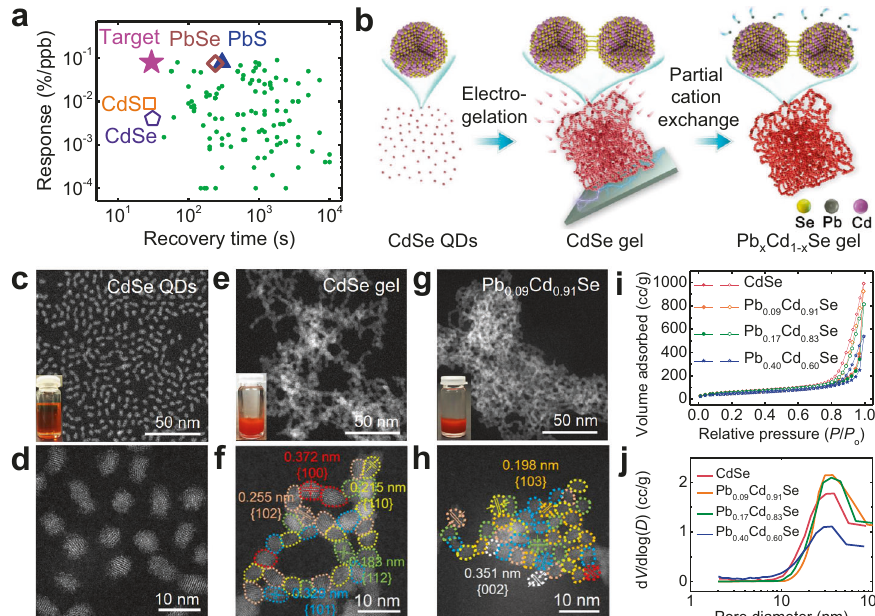
Fig. 1 Synthesis of Pb x Cd 1 − x Se QD gels. a Comparison of CdS, CdSe, PbS, and PbSe QD gels with 110 state-of-the-art room-temperature p-type semiconductor NO 2 sensors in the literature in terms of sensor response and recovery time. b Schematic diagram for the synthesis of Pb x Cd 1 − x Se QD gels ( x = 0.003, 0.02, 0.04, 0.09, 0.17, 0.40, and 1.0) via cation exchange using different Pb(NO 3 ) 2 concentrations. c – h STEM images of c , d CdSe QDs, e , f CdSe gel, and g , h Pb 0.09 Cd 0.91 Se gel at low and high magni fi cation, inset: the corresponding photographs. Crystallites in the high-resolution images are color-coded based on their lattice fringes, corresponding to the {100}, {101}, {102}, {103}, {110}, {112}, and {002} planes of hexagonal CdSe. i Nitrogen adsorption – desorption isotherms and j Barrett – Joyner – Halenda pore-size distributions of CdSe, Pb 0.09 Cd 0.91 Se, Pb 0.17 Cd 0.83 Se, and Pb 0.40 Cd 0.60 Se QD